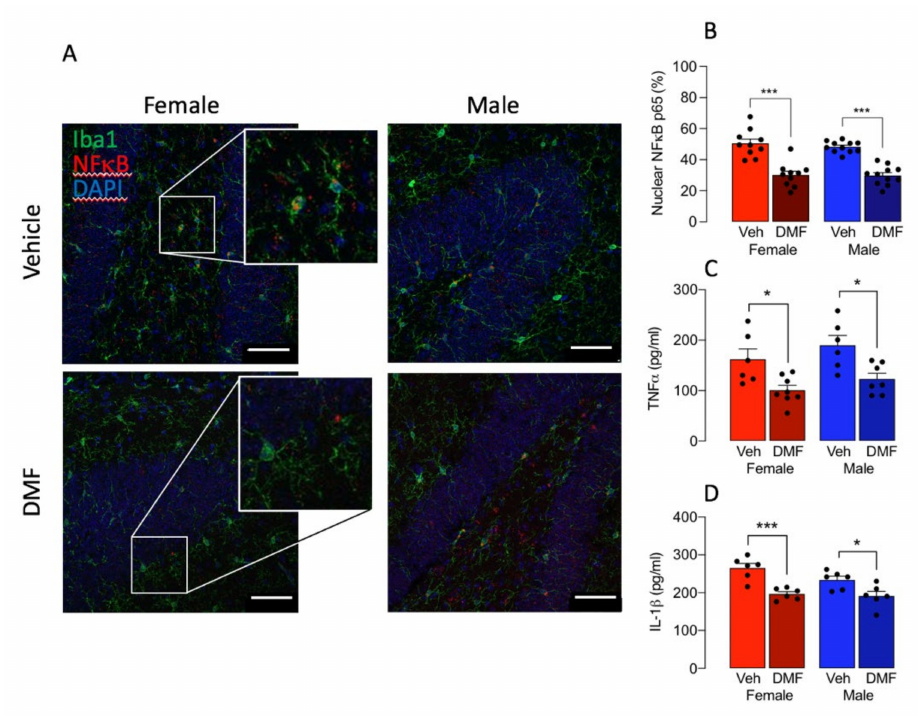
Figure 4. DMF decreases translocation of NF κ B to the nucleus in Iba1 + microglia in hippocampus. A,B. p65 NF κ B expression in DAPI-stained nuclei was assessed in Iba1 + microglia in hippocampal sections prepared from DMF- and vehicle-treated control male and female mice. The sample immunographs and insets ( A ) indicate that DMF decreased NF κ B staining in sections from male and female mice and the higher magnification insets show increased co-localization of NF κ B in DAPI-stained nuclei in control- compared with DMF-treated samples from female mice. Analysis of the mean data ( B ) revealed that there was a significant main effect of treatment ( p < 0.001; 2-way ANOVA) and post hoc analysis indicated that p65 NF κ B + DAPI + staining in Iba1 + cells was significantly decreased in sections from DMF-treated male and female mice compared with the respective controls (*** p < 0.001). Data are expressed as a percentage of the total number of Iba1 + microglia and are presented as means ± SEM ( n = 10 or 11). Scale bar = 50 µ m. ( C , D ) A significant main effect of DMF was observed on hippocampal concentrations of TNF α and IL-1 β (*** p < 0.001) and post hoc analysis indicated significant decreases in tissue from DMF-treated female and male mice compared with their respective vehicle-treated counterparts (* p < 0.05; *** p < 0.001). Data from 2 experiments are presented as means ± SEM ( n = 5 or